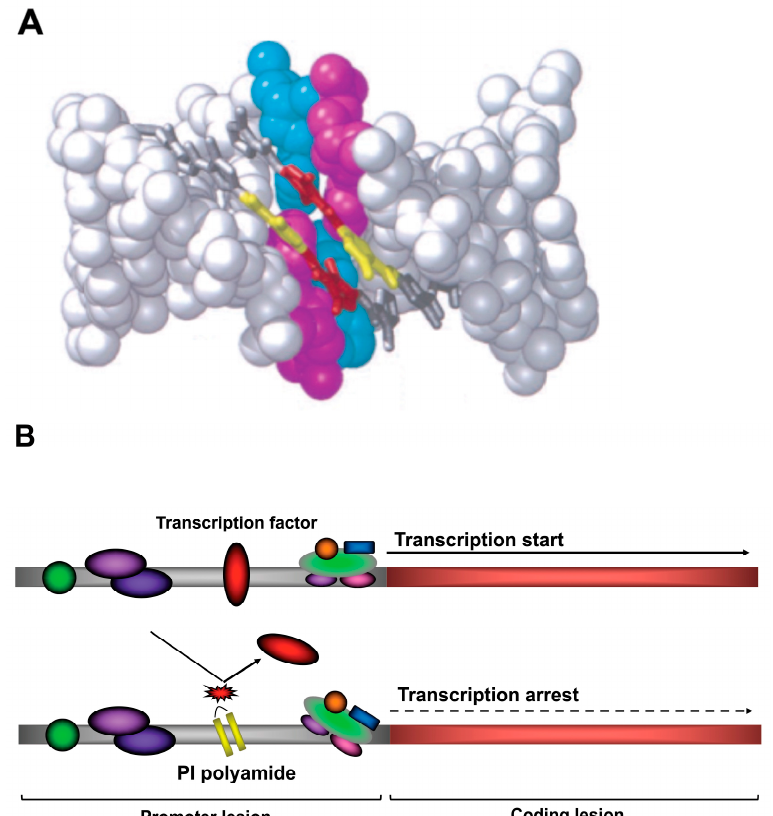
Figure 1. ( A ) Putative binding structures of double-stranded DNA with pyrrole-imidazole (PI) polyamide targeting human transforming growth factor- β 1. Target DNA binding site is indicated by blue and pink colors. PI polyamides are indicated by yallow and red colors. ( B ) Principle of transcriptional suppression of genes. PI polyamides bind to the target promoter region of targeting genes by hydrogen binding to prevent binding of the transcription factors to transcriptionally suppress the gene expression.